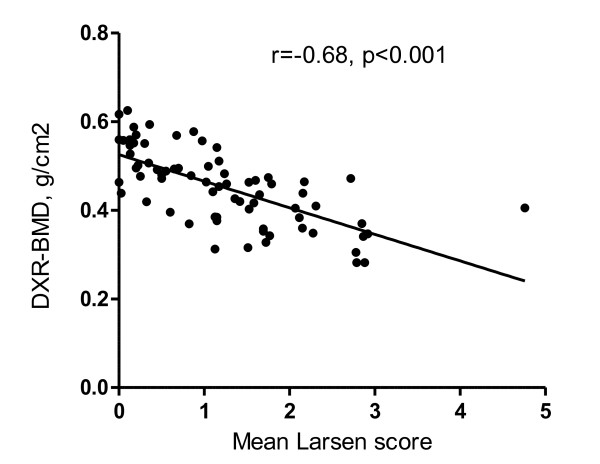
Relation between joint destruction and DXR-BMD. Scatter diagrams of mean Larsen score and bone mineral density by digital X-ray radiogrammetry. The regression line is inserted and Pearson's Correlation (r) is given.